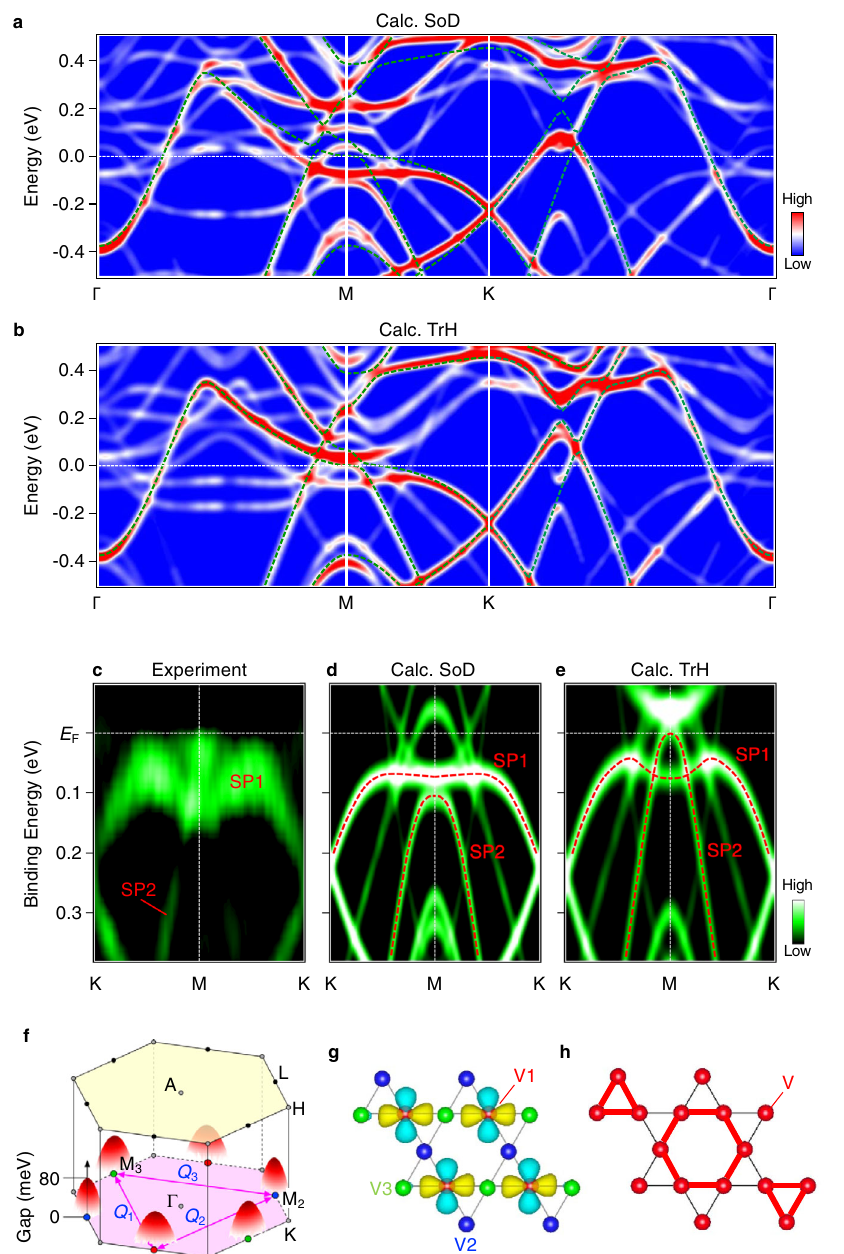
Fig. 3 Calculated band structure and distinction of structural distortions. a , b Calculated band dispersions along the Γ MK Γ cut for the SoD and TrH distortions, respectively. Calculated band dispersions for the undistorted 1 × 1 phase is shown by dashed green curves. Calculations have been performed with the 2 × 2 × 1 superlattice because the in fl uence from the change of unit-cell (doubling or quadrupling) along the c axis was not observed in the ARPES data, as seen from the 2 π c − 1 periodicity of the CDW-gap anisotropy along k z in Fig. 2o. c ARPES intensity at T = 20 K measured along the MK cut at h ν = 114 eV. d , e Calculated band dispersions along the MK cut for the SoD and TrH models, respectively. Red dashed curves are a guide for the eyes to trace the SP1 and SP2 bands. f Schematics of k -dependent CDW gap on the SP1 band, together with the inter-saddle-point scattering vectors Q 1 – Q 3 and three M points, M 1 – M 3 . g Kagome lattice of V atoms with three different sublattices (V1 – V3) shown with different coloring (red, blue, and green spheres, respectively). Calculated Wannier orbital for the SP1 band at one of the M points, which selectively places the V1 sublattice, is also indicated. h Kagome lattice under the TrH distortion in which longer and shorter V – V bonds are highlighted by thick red and thin black lines,